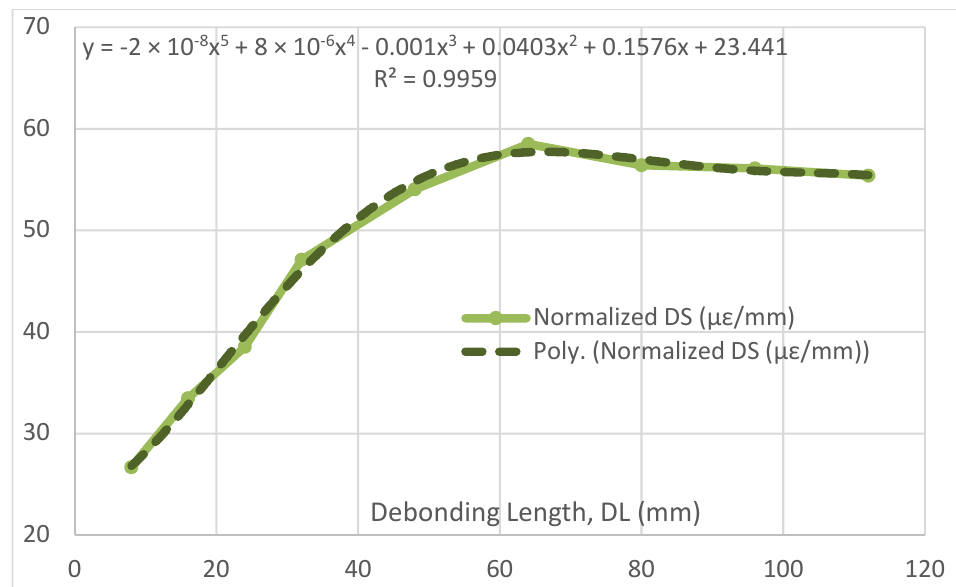
Figure 14. Delta strain as a function of the debonding length, and its polynomial approximation.